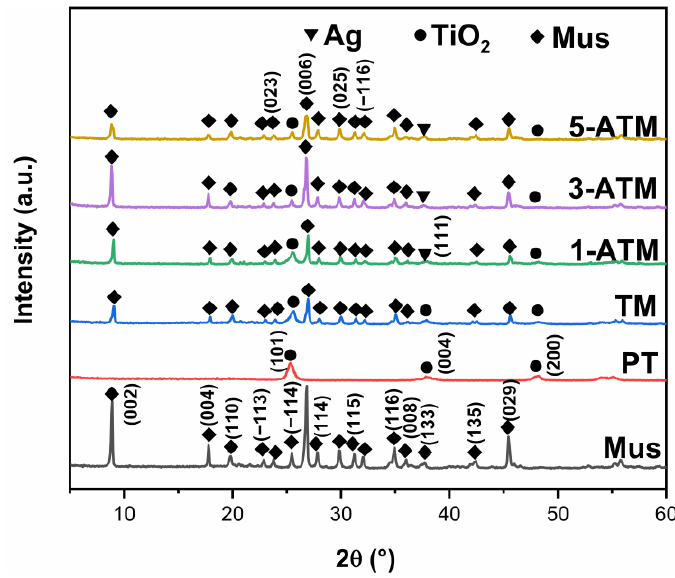
Figure 1. XRD patterns of samples.